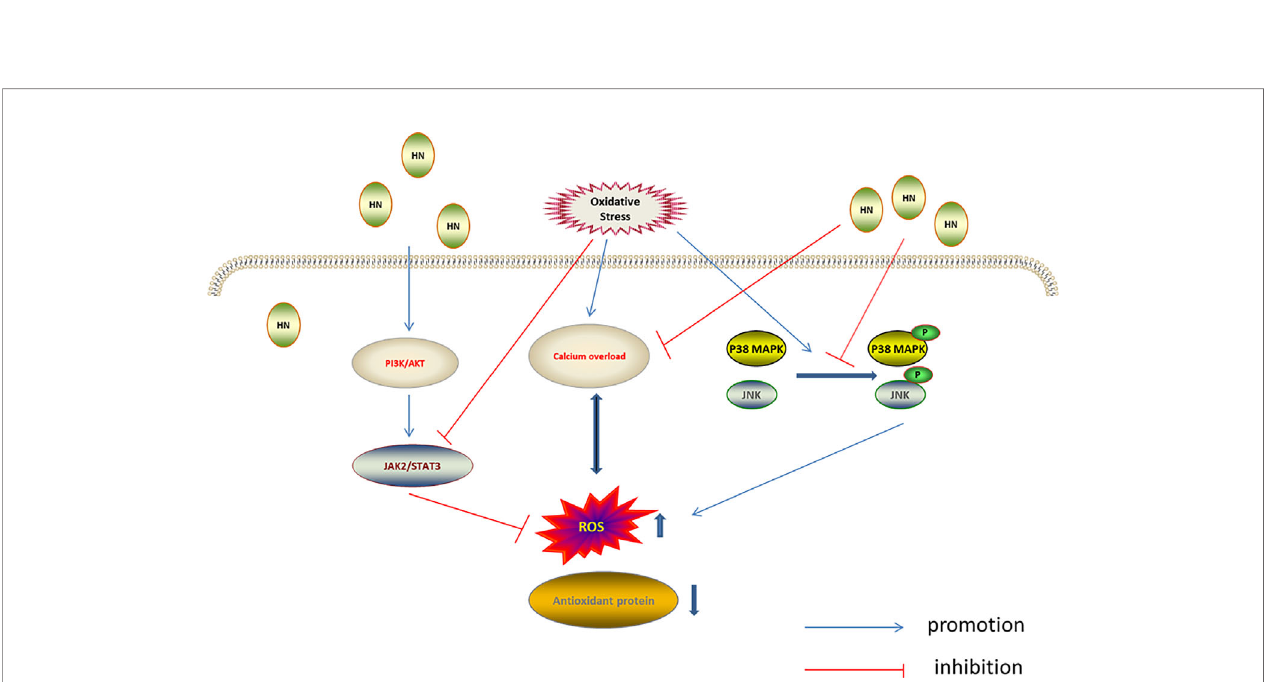
FIGURE 4 | Regulation of HN on MAPKs, PI3K/AKT, and JAK2/STAT3 under oxidative stress. HN inhibits intracellular Ca2 + in fl ux, inhibits ROS formation, activates MAPKs inhibitors, inhibits the activation of JNK and p38 MAPK, and reduces oxidative stress damage; HN activates the PI3K/Akt signaling pathway, which further activates the downstream JAK2/STAT3 signaling pathway, promotes the expression of antioxidant protein, reduces the level of ROS, and reduces the oxidative stress